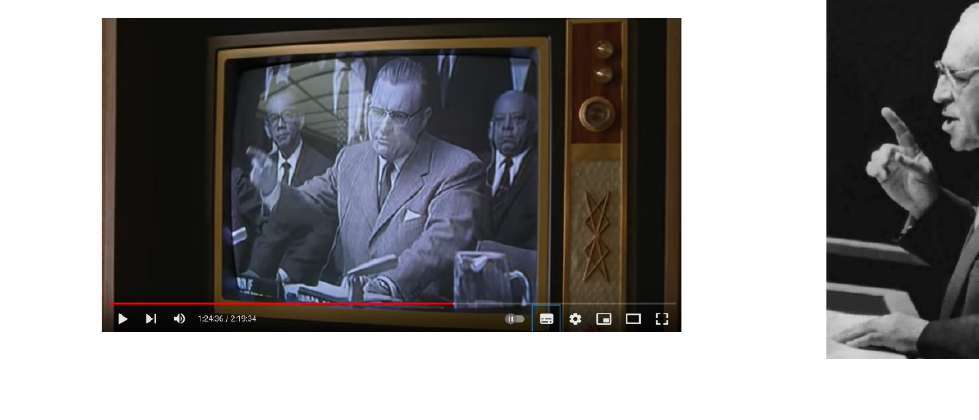
Figure 20 Zorin’s speech in United Nations, film scene Figure 21 Zorin